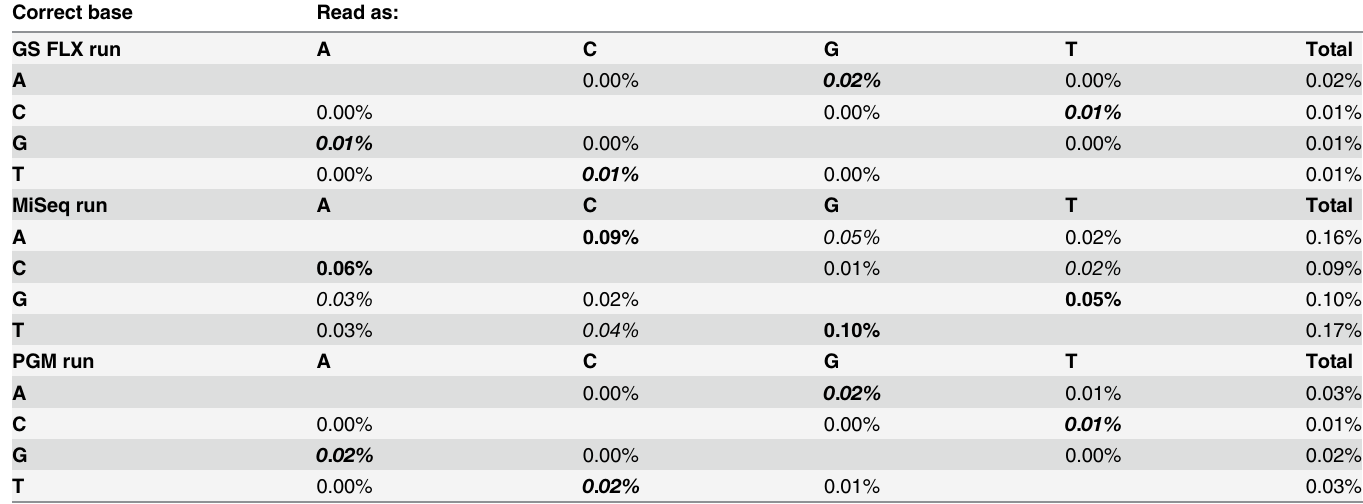
Table 3. Platform comparison — Base-specific error rates. Correct